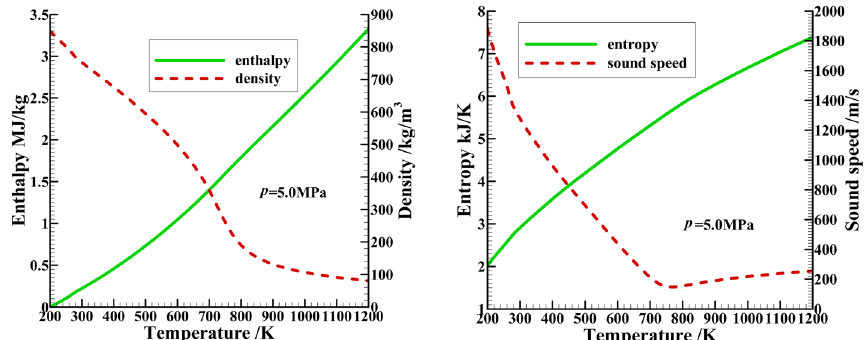
Fig. 3 Thermophysical properties of China RP-3 aviation kerosene estimated using the present surrogate, (a) enthalpy and density; (b) entropy and sound